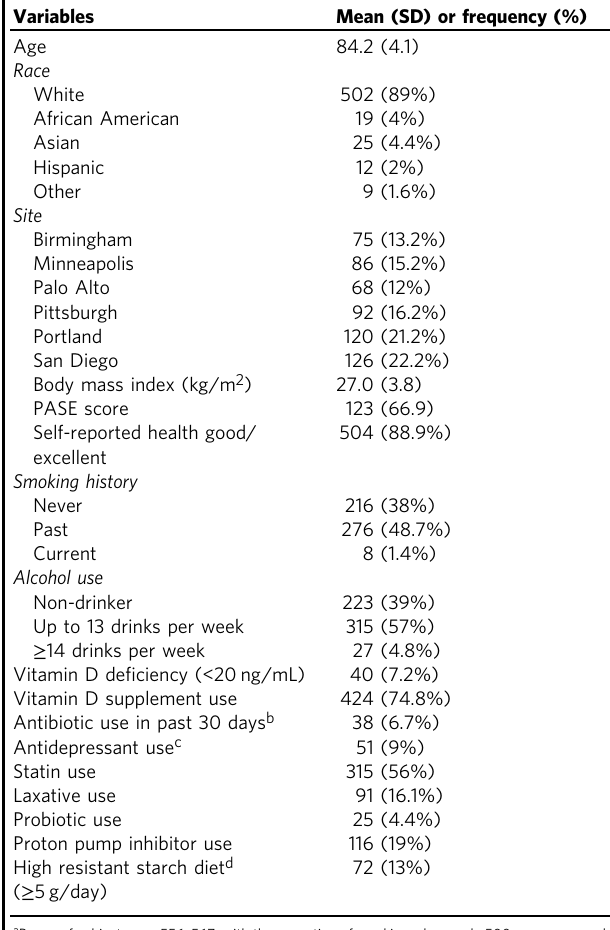
Table 1 Baseline characteristics of study participants ( n = 567) a